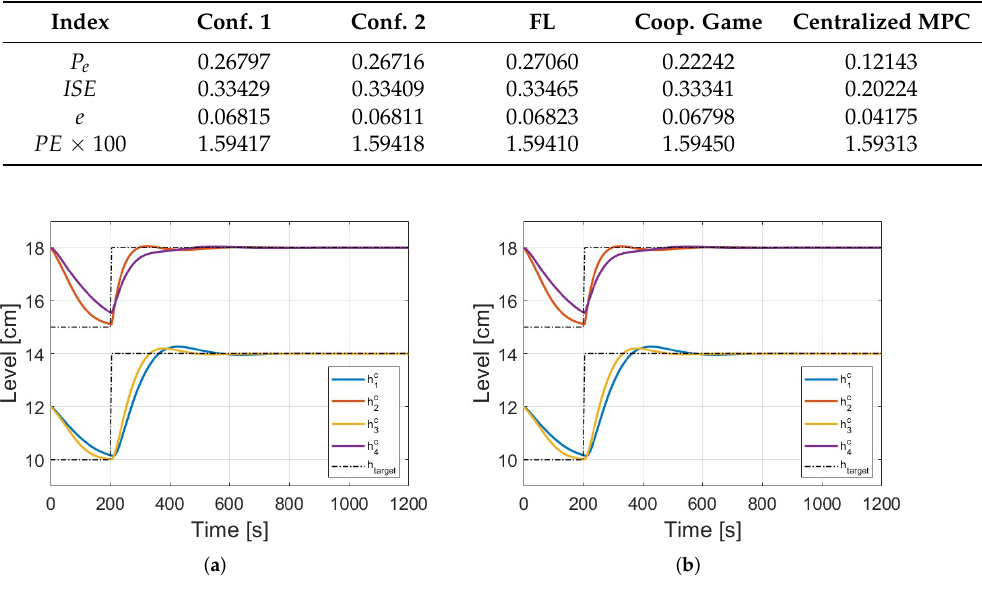
Table 5. Case 3: Configurations performance through performance indices values.